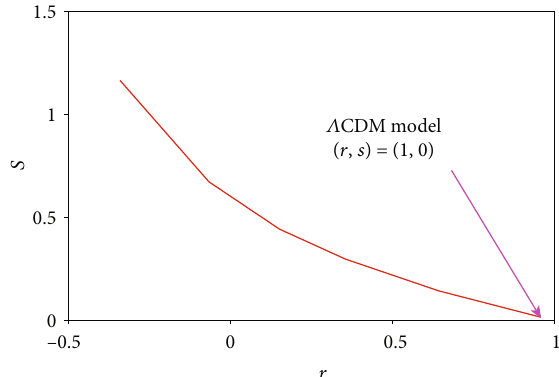
Figure 5: The plot of r versus s plane for ξ = 0 : 6 , l = 0 : 6 , and b = 0 : 5 .